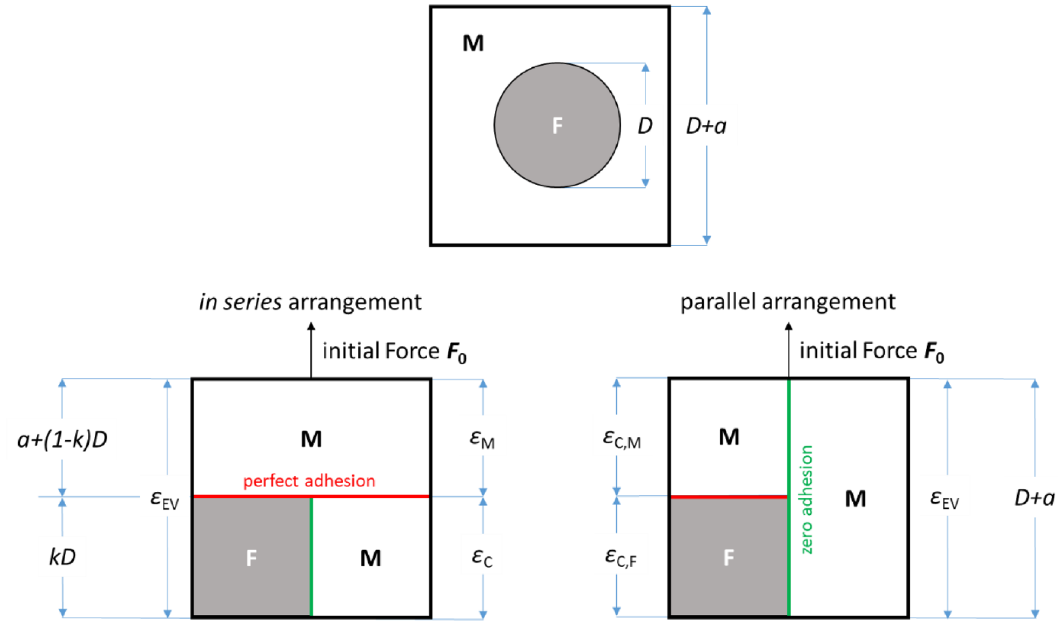
Figure 1. Cubic elementary volume (EV) containing a spherical inclusion with diameter D and distance a between inclusions (top), and its cube in cube consideration in series and parallel arrangements with adhesion boundary